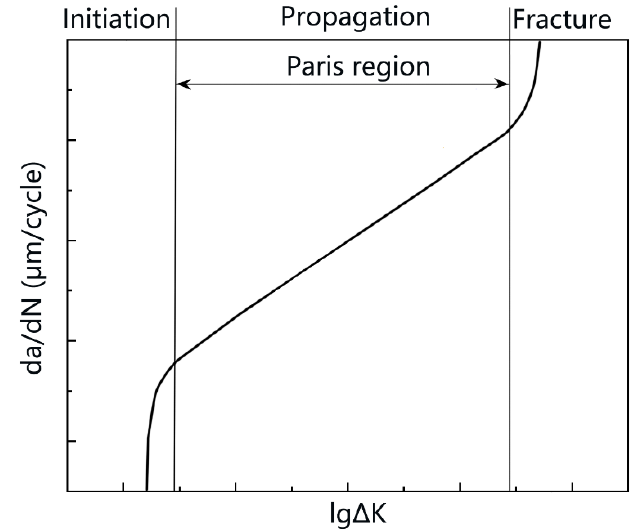
Figure 1. The different stages of fatigue crack growth. The Paris formula is suitable for describing the propagation